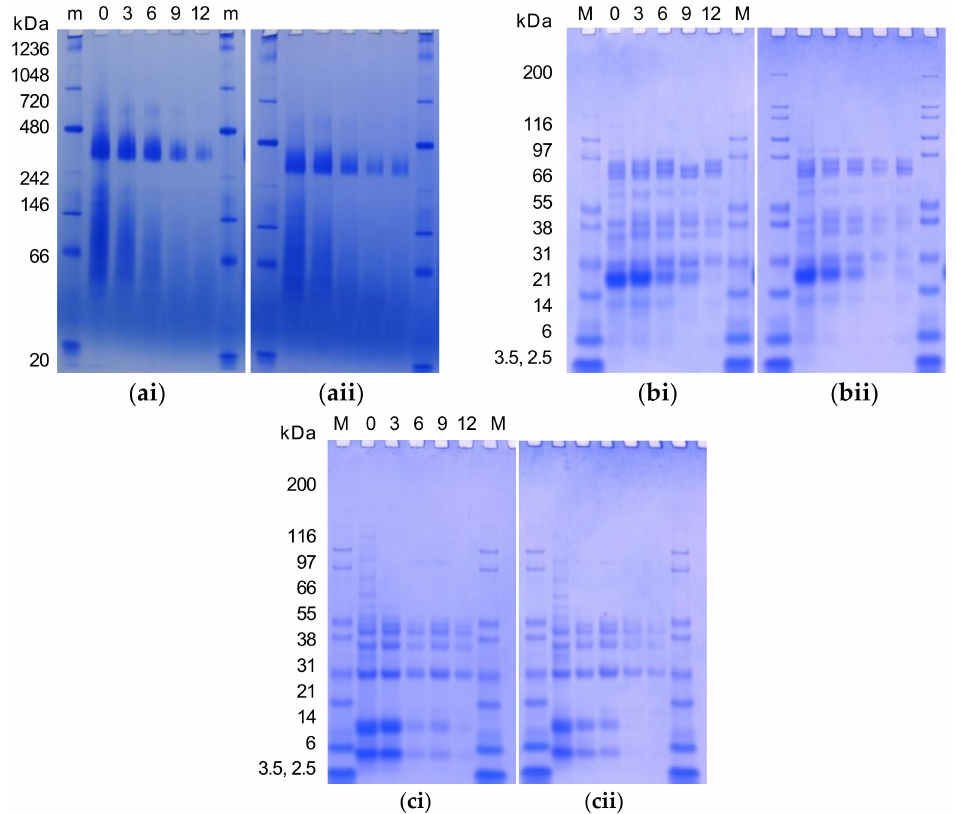
Figure 1. Native gel electrophoresis ( a ), and SDS-PAGE (non-reduced, ( b )) and (reduced, ( c )) water-soluble (pH 7) protein profile of cold-pressed (20 ◦ C, ( i )) and expeller (100 ◦ C, ( ii )) canola meal with moist heat pressure treatment for different durations (0, 3, 6, 9 or 12 min) revealed with Coomassie Blue Stain. Representative images presented. A 30 µ g aliquot of each sample was loaded per well. A 5 µ L aliquot of NativeMark™ Unstained Protein Standard (m) or Mark 12 Protein Standard (M) was